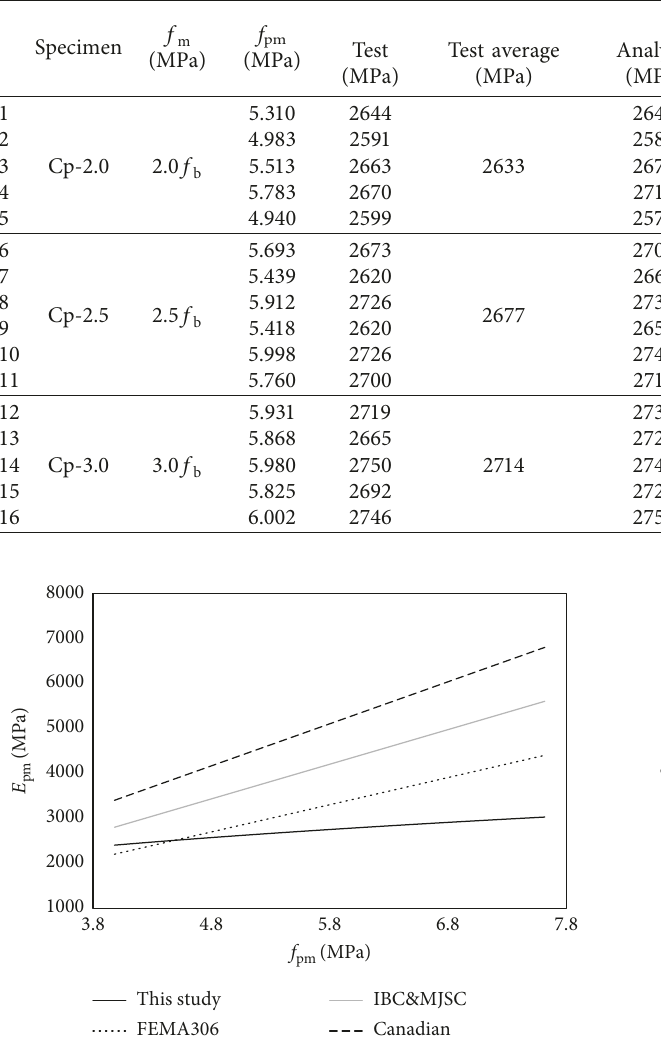
Figure 8: Comparison of proposed E